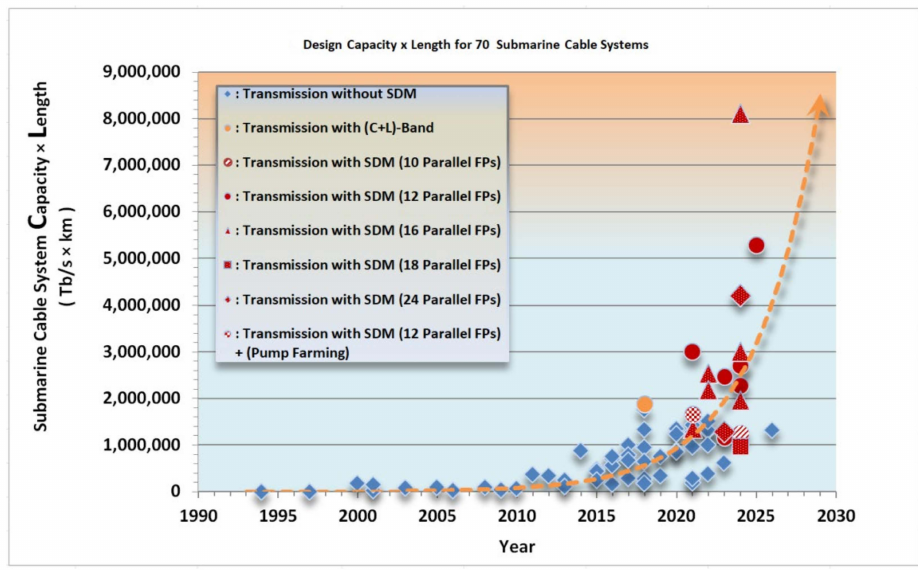
Figure 14. Submarine cable system capacity × cable length through time for 70 different cable